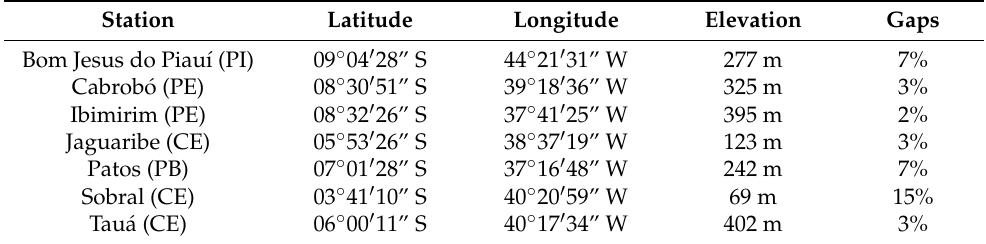
Table 1. Location of the seven municipalities located within or in the surroundings of each desertifi- cation hotspot in the NEB, as shown in Figure 1: PI, Piau í state; PE, Pernambuco state; CE, Cear á state; PB, Para í ba state.